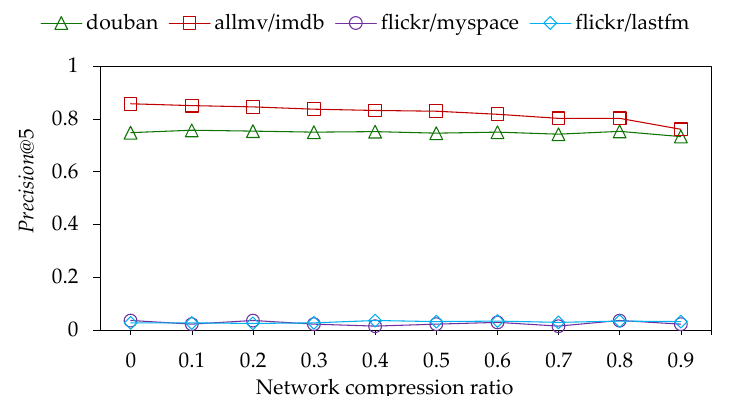
Figure 3. Effect of compression ratio on Precision @5.